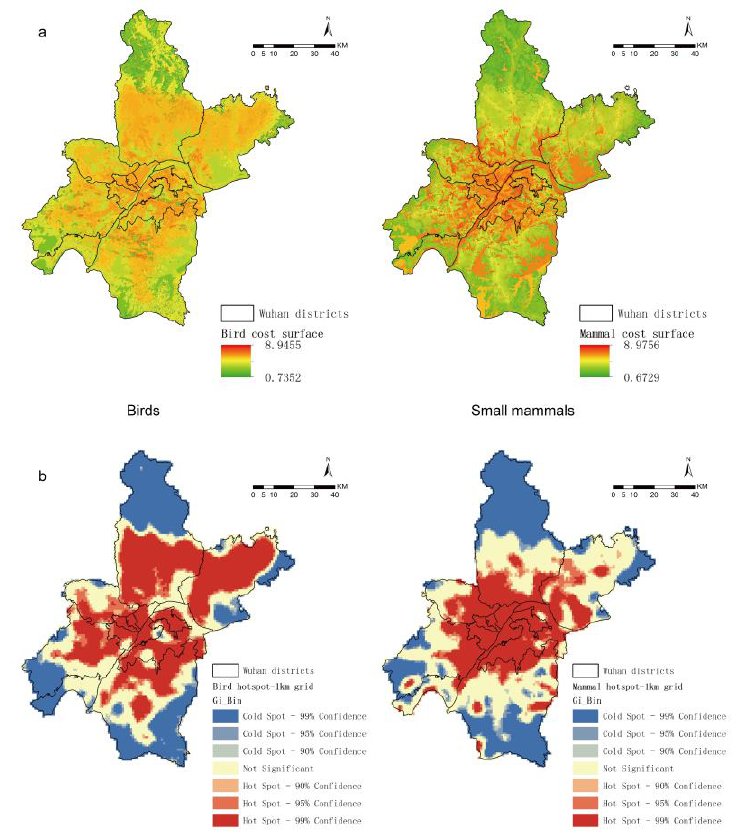
Figure 4. Cost surface analysis. ( a ) Cost surface distribution, ( b ) Hotspot analysis.